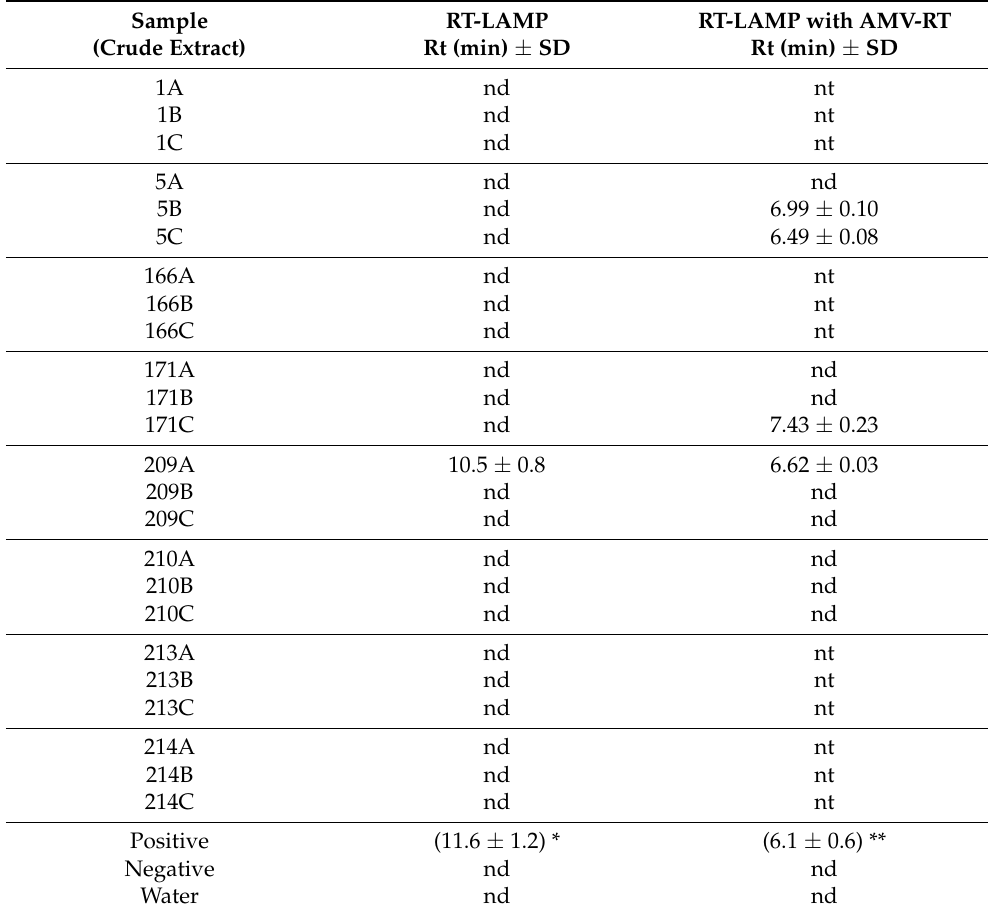
Table 7. Detection of SBCMV using RT-LAMP mix and RT-LAMP mix containing AMV-RT in leaf crude extracts (dilution 10 − 4 ) of 24 samples from durum wheat plants grown in SBCMV-infected soil. Experiment was performed in the bCUBE instrument. Rt: reaction time; SD: standard deviation; nd: not detected; nt: not